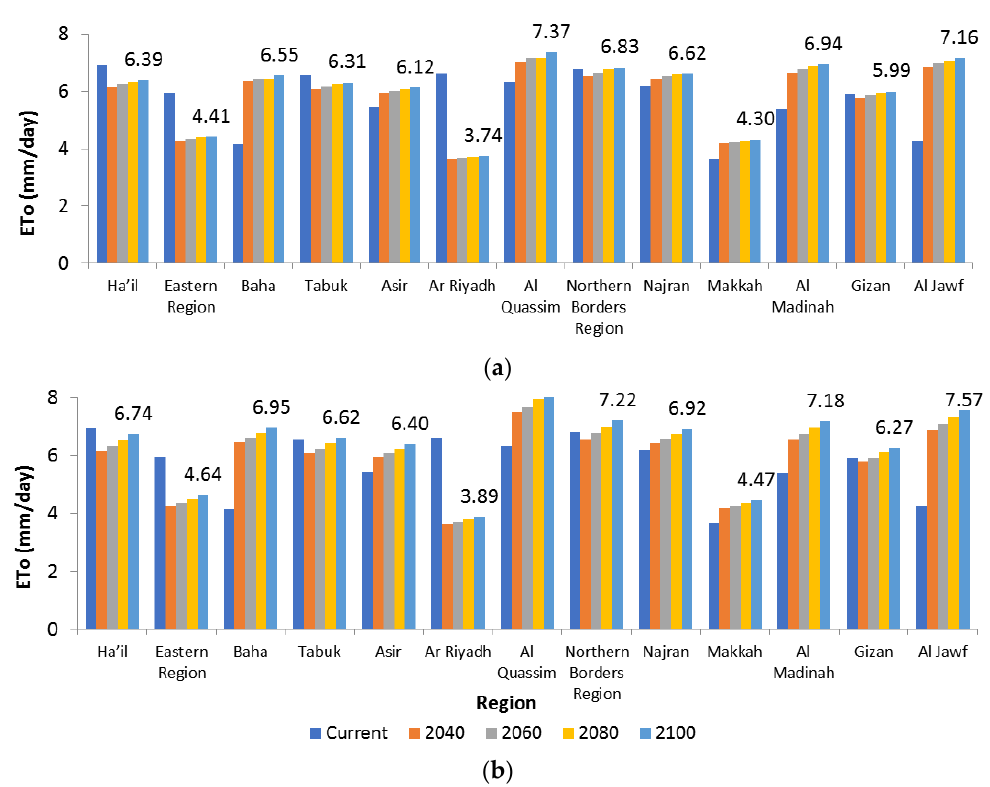
Figure 7. Estimated annual-averaged ETo (mm) under SSP2-4.5 ( a ) and SSP5-8.5 ( b ) for 2040, 2060, 2080, and 2100, using average data from the four CMIP6 climate models and the current 2020 data.